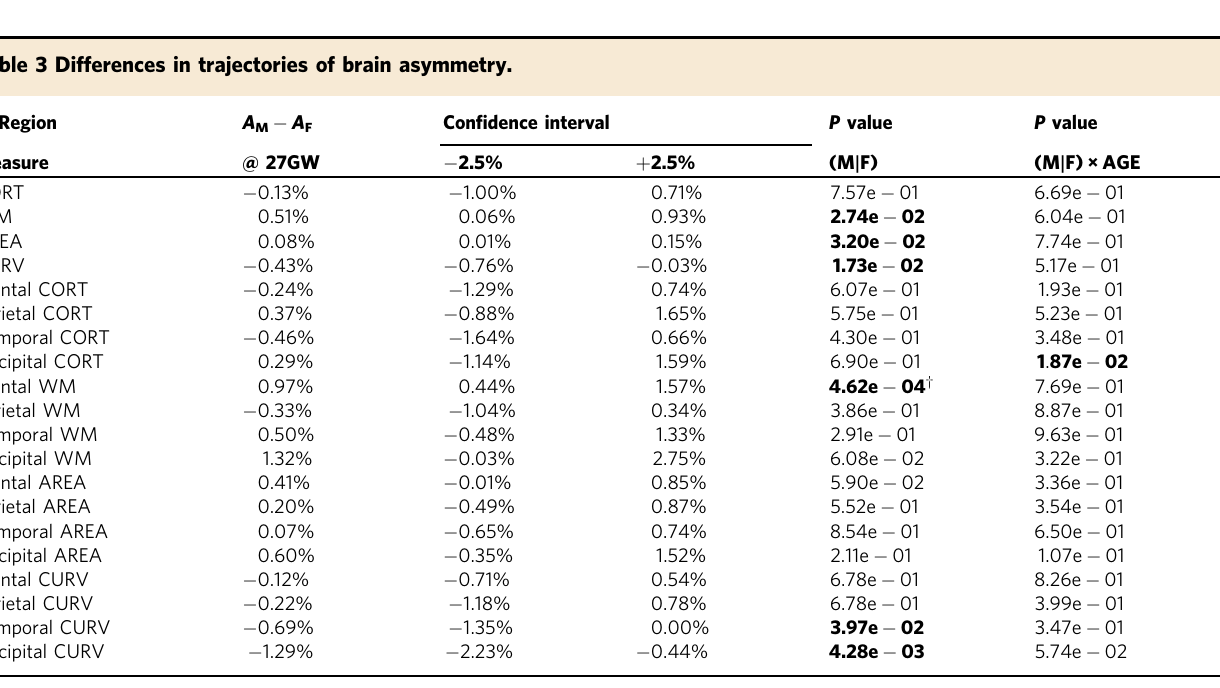
The estimated sex-related difference A M − A F in the asymmetry A = R RIGHT – R LEFT from left to right, and the upper and lower 95% con fi dence bounds on this difference estimate. CORT cortical tissue volume, WM combined white matter/developing white matter tissue volume, DGM combined deep gray matter volume, CURV mean surface curvature averaged over the speci fi ed portion of the brain surface, AREA surface area of total brain or lobe region. Therighttwocolumnsarethestatisticalsigni fi cance(uncorrected P value)ofthismale − femaledifferenceandofitschangewithgestationalage.Boldindicates P <0.05forthemale − femaletrajectory difference and dagger † indicates that this signi fi cance survives correction for multiple comparisons across the 20 two-sided hypothesis tests in this